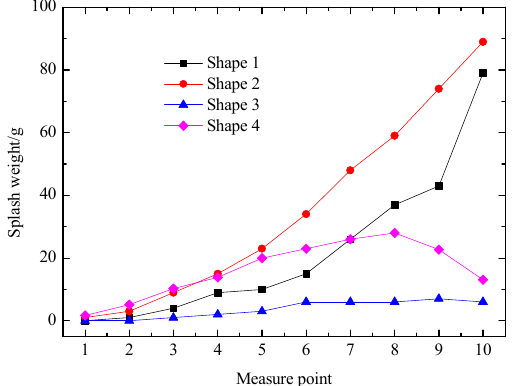
Figure 10. Splash weight at the bottom of the left slope in the physical model test.